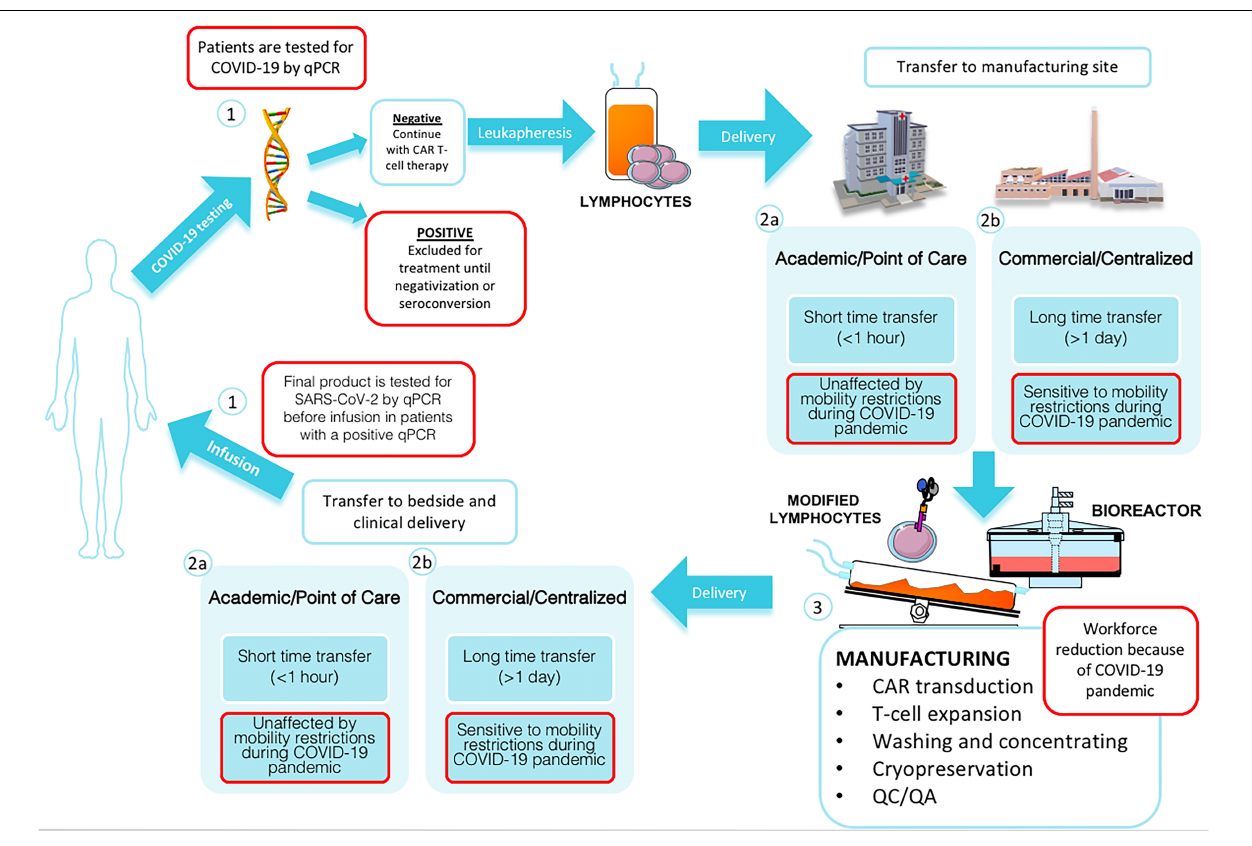
FIGURE 1 | Standardized CAR T-cell manufacturing process during COVID-19 pandemic. Patients have to be tested by qPCR for SARS-Cov2 before leukapheresis (1); in case of a negative result, peripheral blood mononuclear cells (PBMCs) are collected from patient via leukapheresis. Timing of delivery to manufacturing site and the susceptibility to mobility restriction varies between Academic/Point of Care (2a) and Commercial/centralized (2b) production. Manufacturing process is affected by workforce reduction (3). T-cells are selected, activated, transduced with a viral or non-viral vector to express the desired CAR and expanded in a bioreactor. After that, resulting CAR T-cells are isolated and cryopreservated and assessed by quality control (QC) and quality assurance (QA) programs. Finally, the patient’s modified own cells are transferred to bedside. Timing of delivery to bedside and the susceptibility to mobility restriction varies between Academic/Point of Care (2a) and Commercial/centralized (2b) production. Before CAR T-cell product infusion, final product is tested for SARS-CoV-2 by qPCR before infusion in patients with a positive qPCR result prior to leukapaheresis